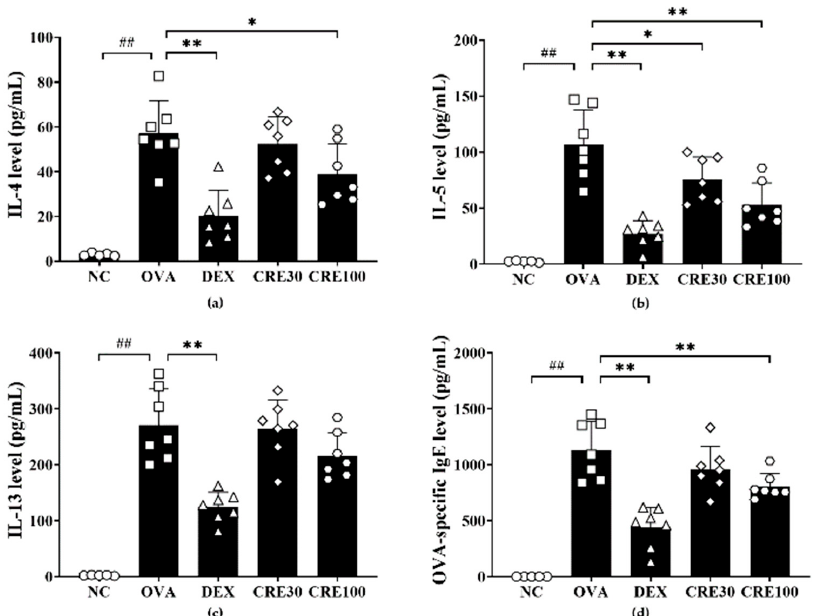
Figure 3. CRE decreased inflammatory cytokines and OVA-specific IgE in animals with asthma. ( a ) IL-4, ( b ) IL-5, ( c ) IL-13, ( d ) OVA-specific IgE. NC: PBS treatment and PBS challenge; OVA: PBS treatment and OVA challenge; DEX: dexamethasone (2 mg/kg) treatment and OVA challenge; CRE30 and CRE100: CRE (30 mg/kg and 100 mg/kg, respectively) and OVA challenge. The values are shown as the mean ± SD ( n = 5–7). ## p < 0.01 versus NC; *, ** p < 0.05 and 0.01 versus